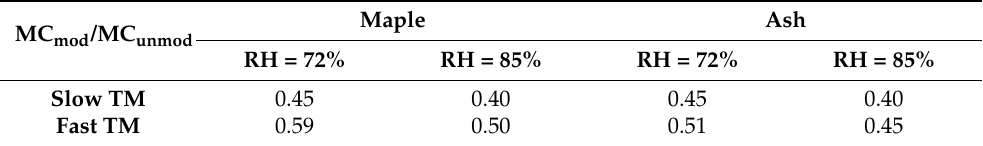
Table 2. EMC ratios (MC mod /MC unmod ) for slow and fast treatment at 20 ◦ C and two RH values. MC mod /MC unmod